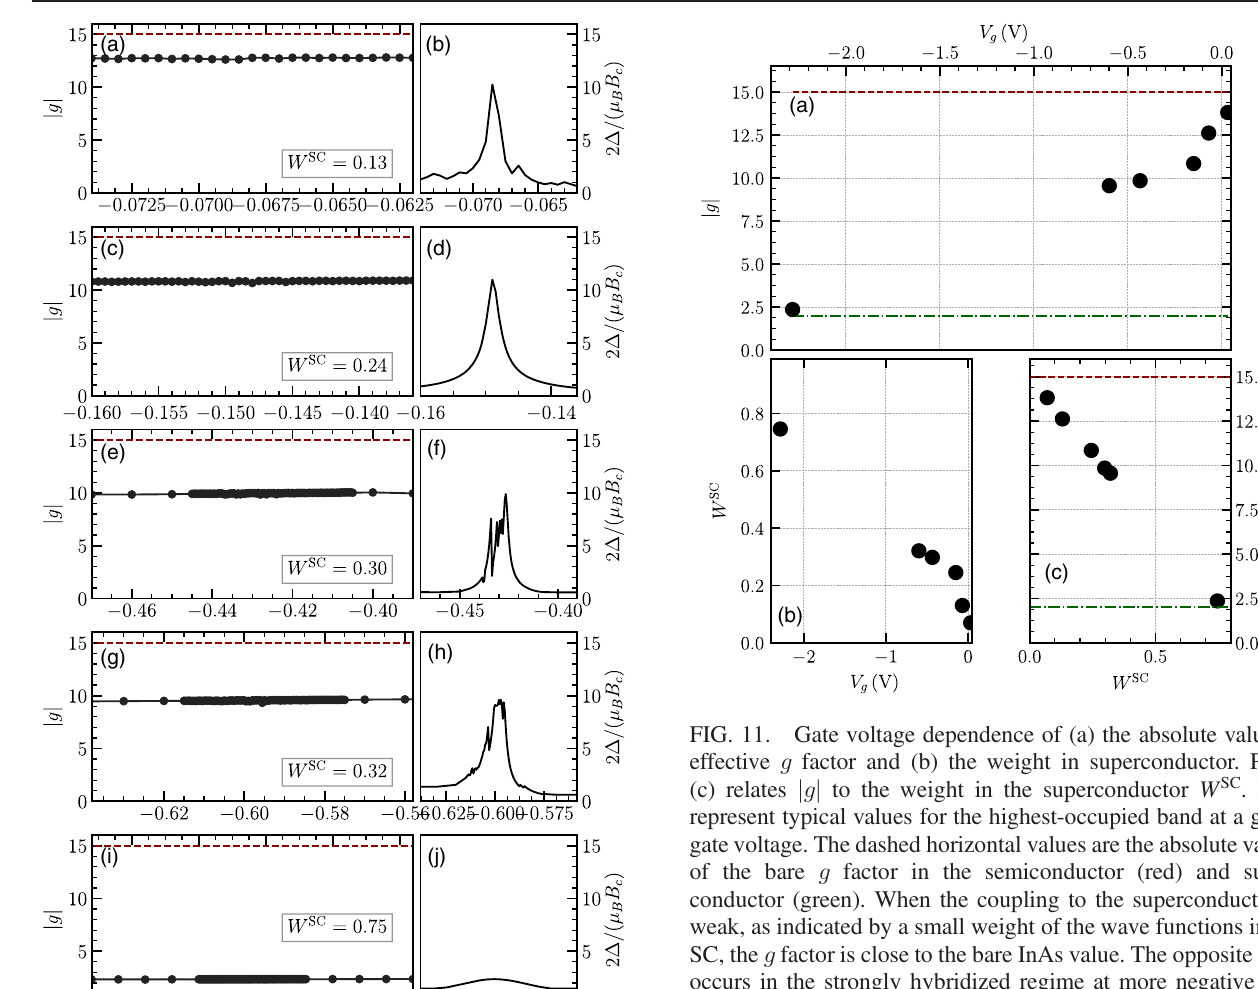
B B c Þ − 0 . 07 (a),(b), − 0 . 15 (c),(d), g ¼ j SM